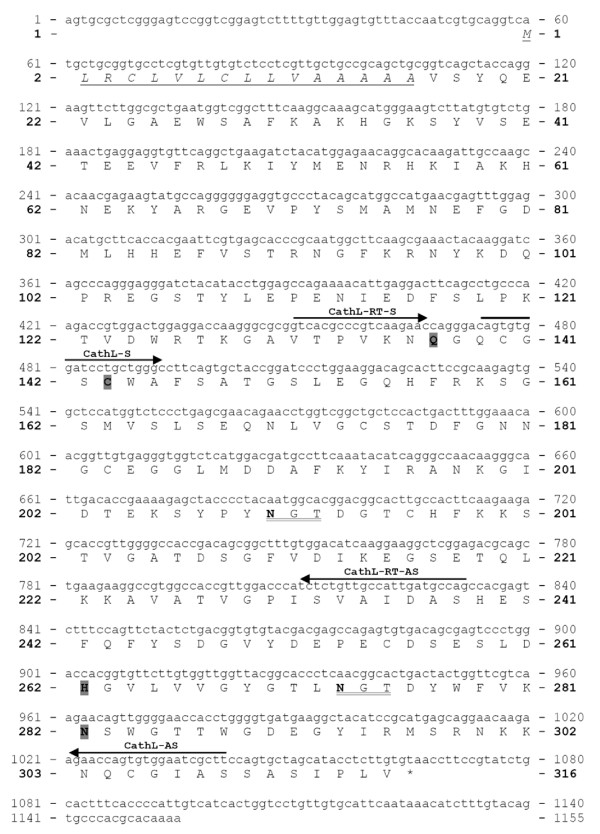
Nucleotide and deduced amino acid sequence of Ixodes ricinus cathepsin L (IrCL). The depictions of PCR primers, putative 16 AA signal peptide, two potential N-glycosylation sites and active site residues C143, H262, Q137 and N282 are as in Fig 4.